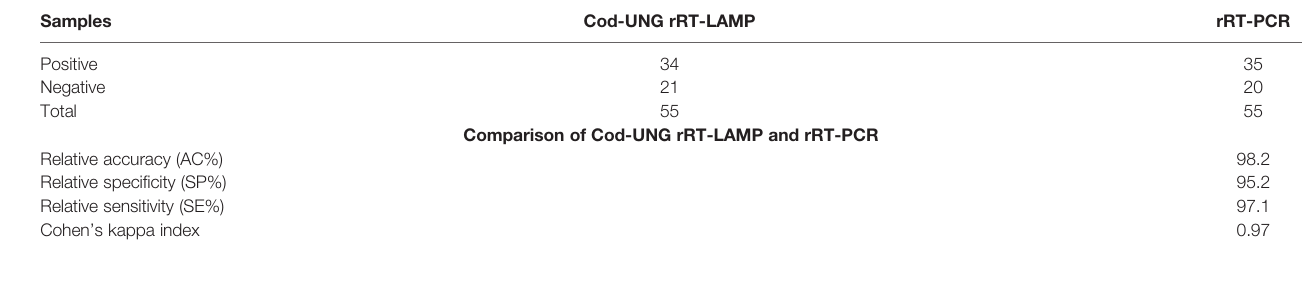
TABLE 2 | Comparison of the Cod-UDG-rRT-LAMP assay to rRT-PCR for detection of SARS-CoV-2 in 55 clinical samples. Samples